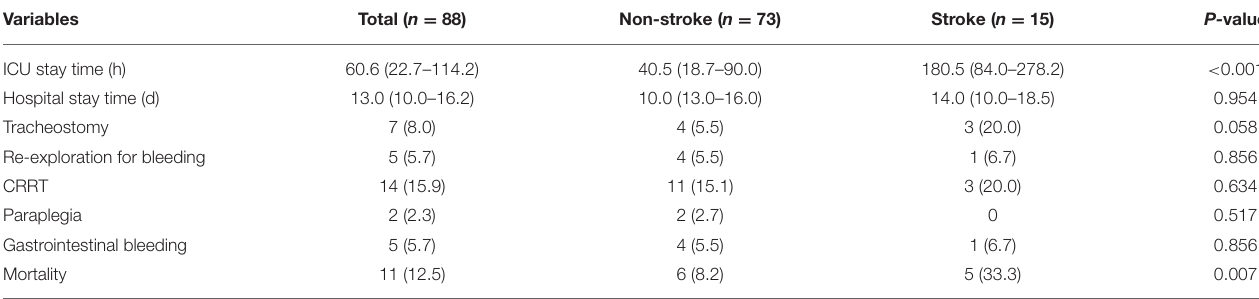
TABLE 2 | Patient mortality and